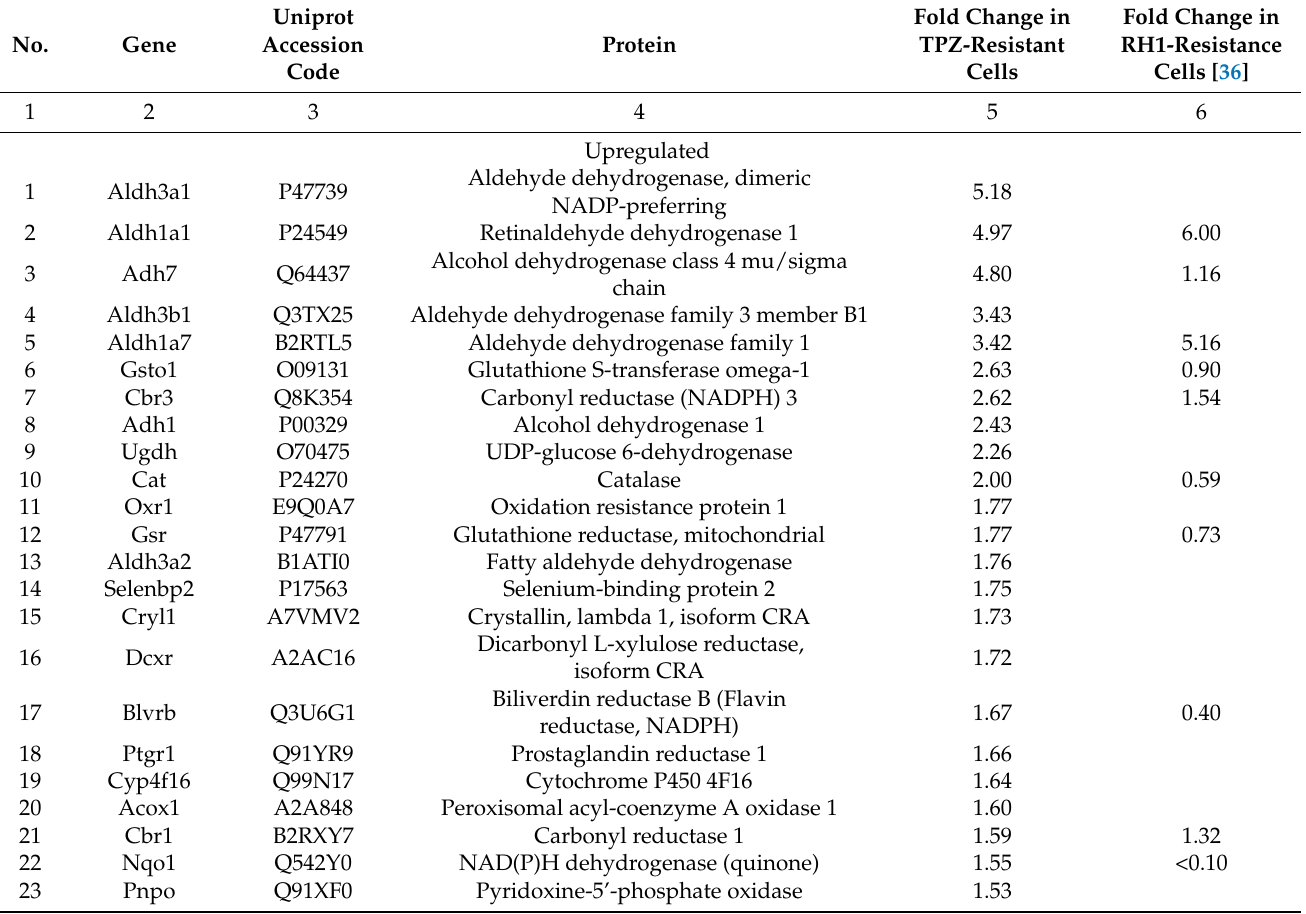
Table 1. Differently expressed oxidoreductase proteins in TPZ-resistant MH22a